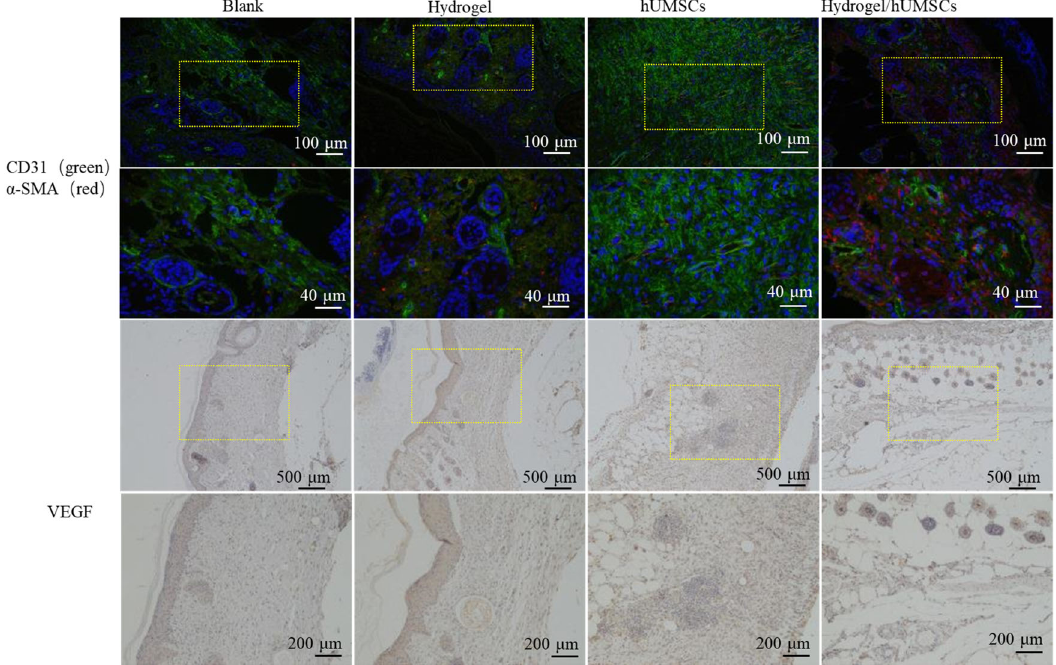
Fig. 7 Hydrogel-hUMSCs combined treatment promotes angiogenesis and re-epithelialization. Expression of CD31, α -SMA and VEGF at the wound sites of rats in the control, the hydrogel and hUMSCs alone or